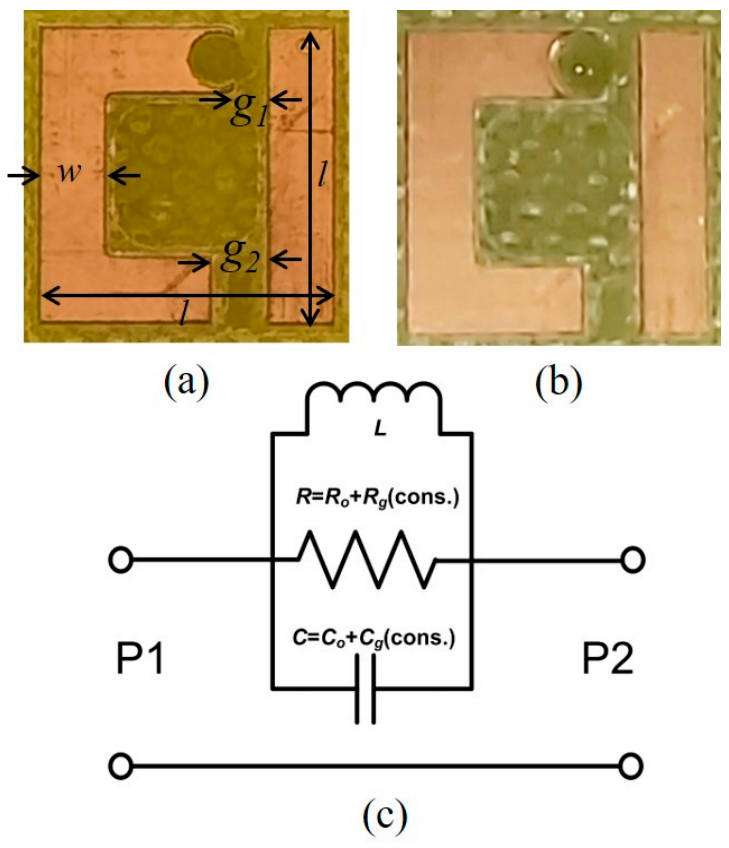
Figure 1. The fabricated single metamaterial asymmetric double split resonator showing the important dimensions: without the solution drop ( a ); and with the solution drop ( b ). ( c ) The equivalent circuit model with P1 and P2 representing the input and output ports, respectively.